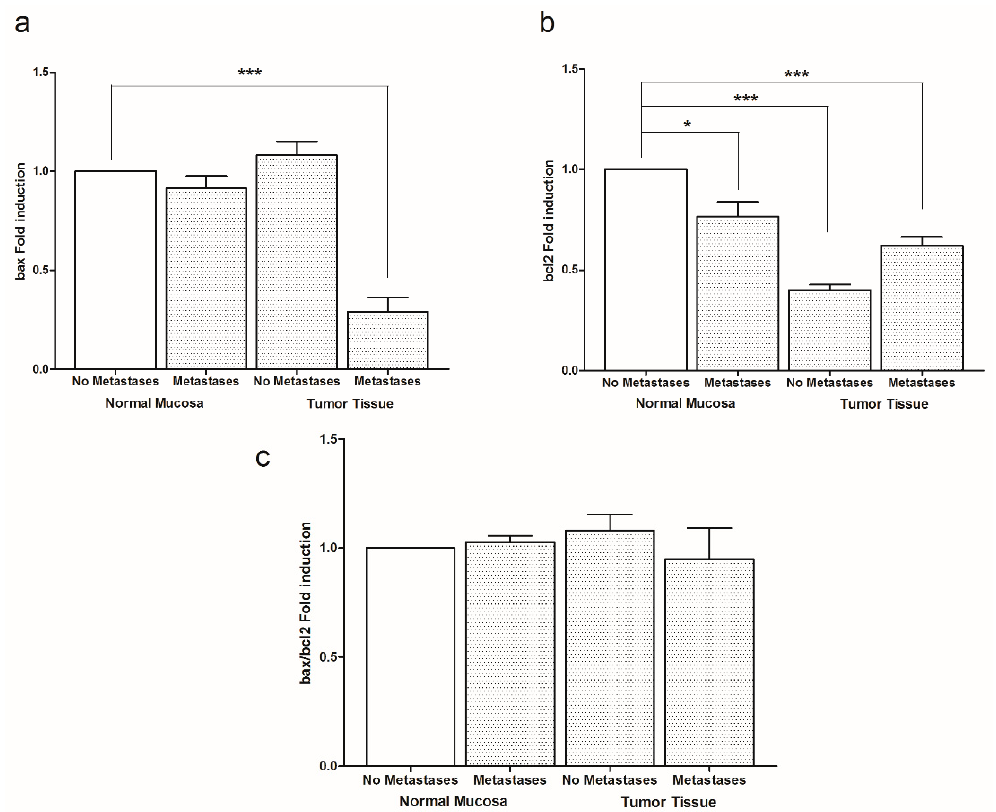
Figure 5. Transcriptional analysis of bax ( a ) and bcl2 ( b ) genes in intestinal tissue of no metastasis ( n = 29 patients) and with metastasis patients ( n = 30 patients) detected in both normal mucosa and tumor tissue. ( c ) shows the levels of bax/bcl2 ratio detected in the same intestinal samples. Data, expressed as mean value ± SD, are presented as fold induction compared to normal mucosa of patients without metastases * p < 0.05, *** p < 0.001 indicate significant differences (one-way analysis of variance and Dunnett’s multiple comparison test).